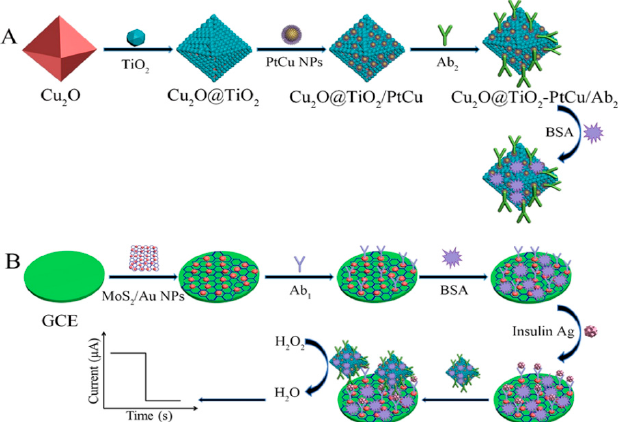
Figure 7. ( A ) Preparation process of PtCu NPs-Cu 2 O@TiO 2 -Ab2 and ( B ) the fabricated process of the proposed sandwich-type immunosensor. Reproduced with permission from